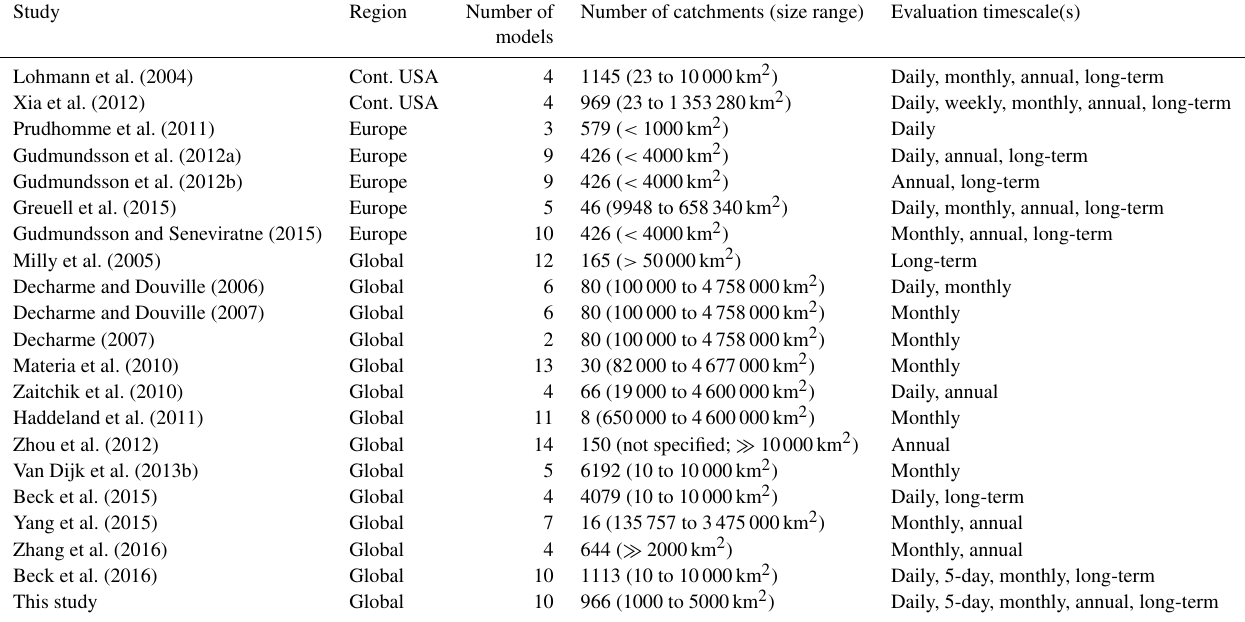
Table 1. Overview of, to the best of our knowledge, all macro-scale (continental to global) studies evaluating the runoff estimates of multiple models, sorted by region and then publication date. The present study has been added for the sake of